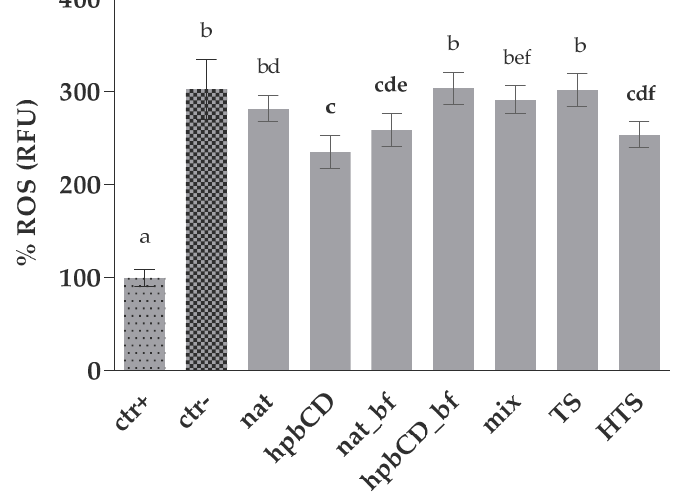
Figure 2. Protective effect of OPEs and pure polyphenols against oxidative stress on HepG2 ROS generation. Data are presented as mean ± standard deviation ( n = 3) of the relative fluorescence units (RFU) calculated according to Equation (2); Positive control cells (ctr+) were treated with PBS while negative control cells (ctr − ) were treated with tBOOH. All the other cells were treated both with samples and tBOOH. The final concentrations of the samples in wells are noted in Table 1. Different letters (a, b, c, d, e, f) indicate statistically significant differences compared to ctr+ ( p < 0.05). Native olive pomace extract (nat), olive pomace extract with hydroxypropyl β -cyclodextrin (hpbCD); bioaccessible fraction (bf), tyrosol (TS), hydroxytyrosol (HTS), TS and HTS in the same concentration as in native sample (mix).